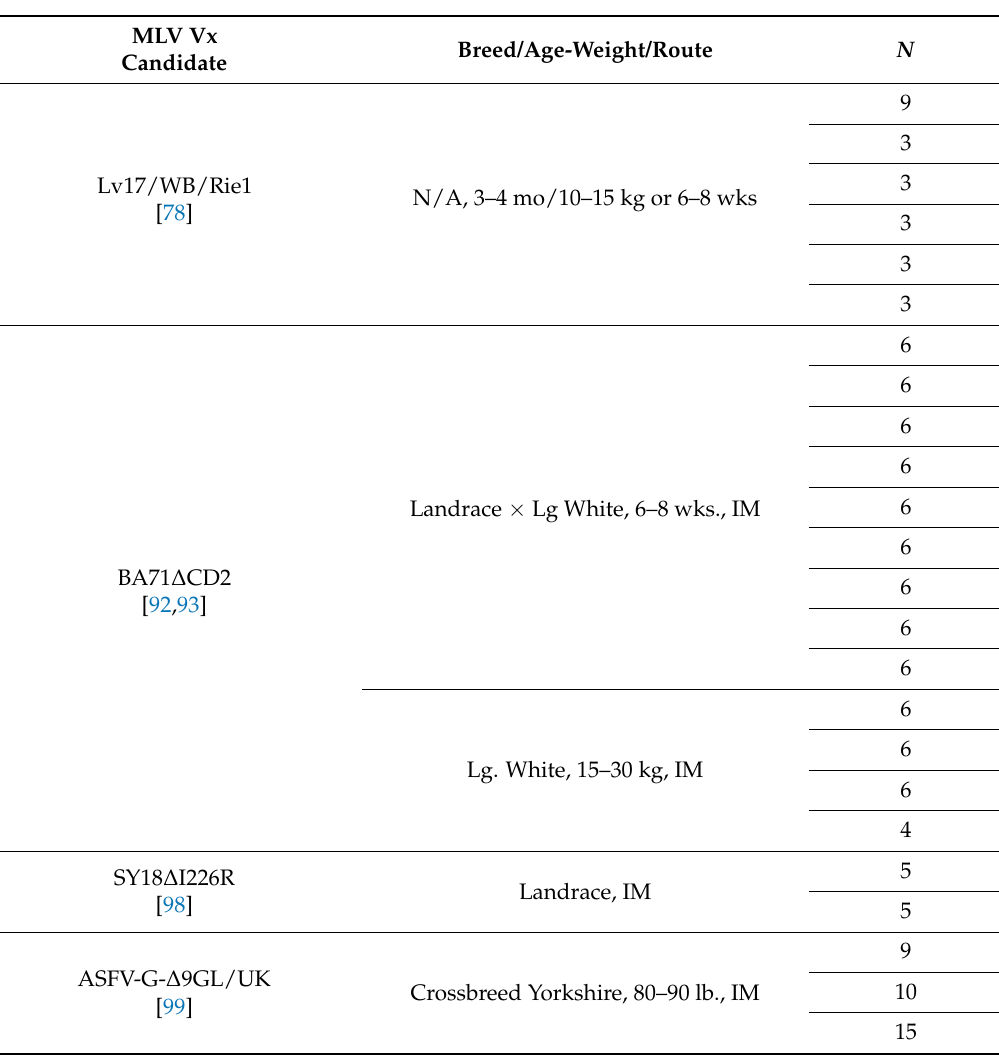
Table 2. Clinical Models to Assess MLV Vaccine Candidate